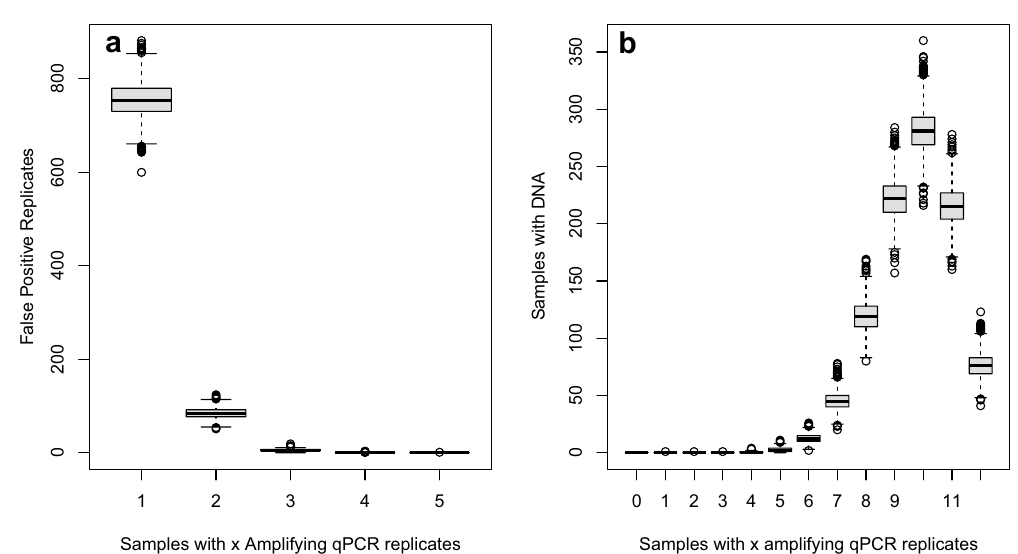
Samples with x Amplifying qPCR replicates Figure 2. Goodness of fit summary of the number of ( a ) simulated false positives qPCR replicates in a sample, when DNA is not present, at Stage 2 and ( b ) simulated number of positive qPCRs for samples with DNA present at Stage 2. 0 represents samples where all qPCR replicates are incorrect, while 12 represents samples where all qPCR replicates are